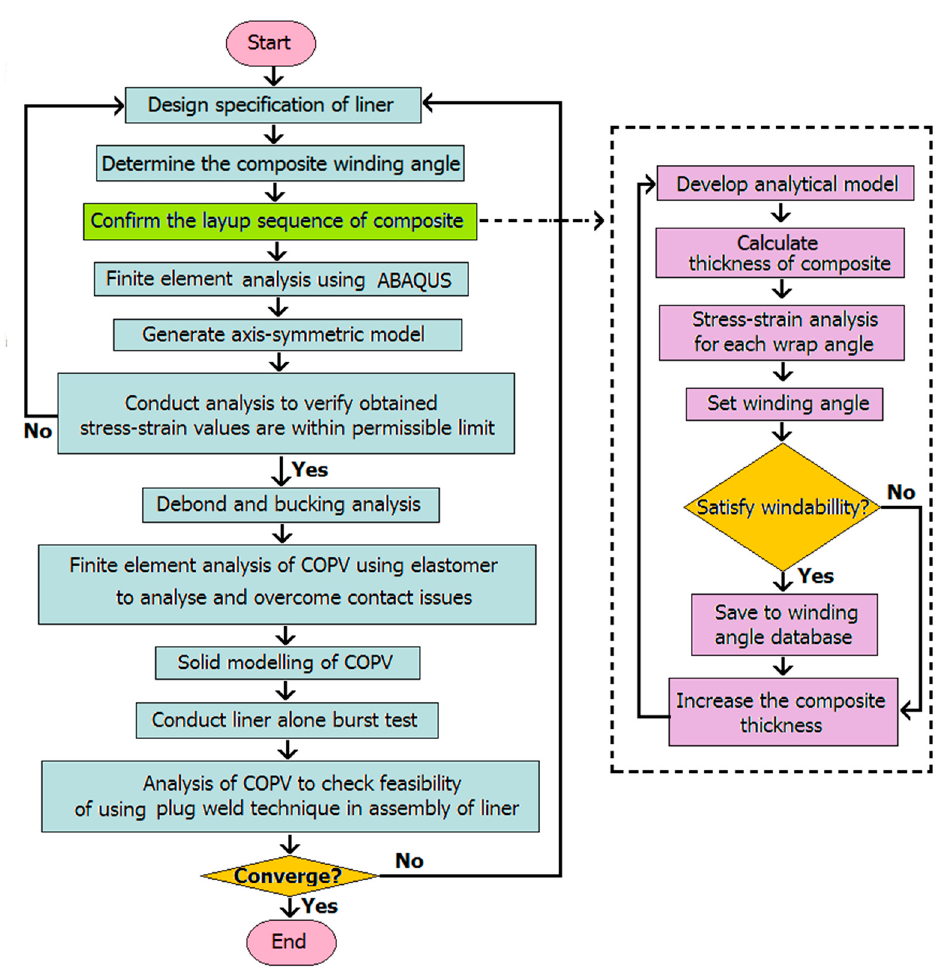
Figure 17. Flow chart of finite element modeling of a composite vessel [82].